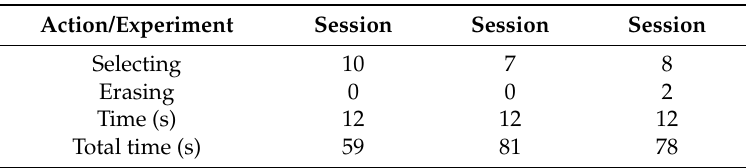
Figure 5. Users interacting with the system. (The y-axis represents the number of letters that each user selected in each experiment. The x-axis represents the particular session.)